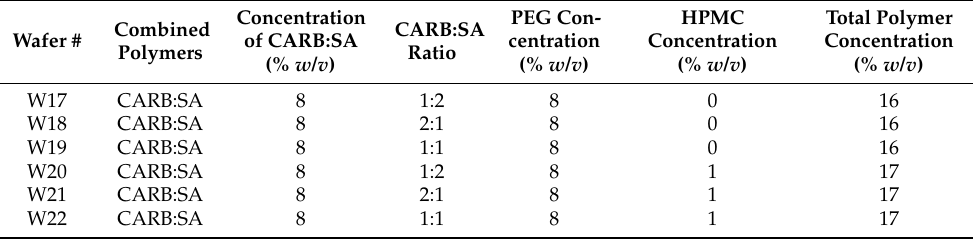
Table 3. Blank (BLK) composite CARB:SA gels (8% w/v ) loaded with 8% PEG with or without HPMC showing different ratios of the